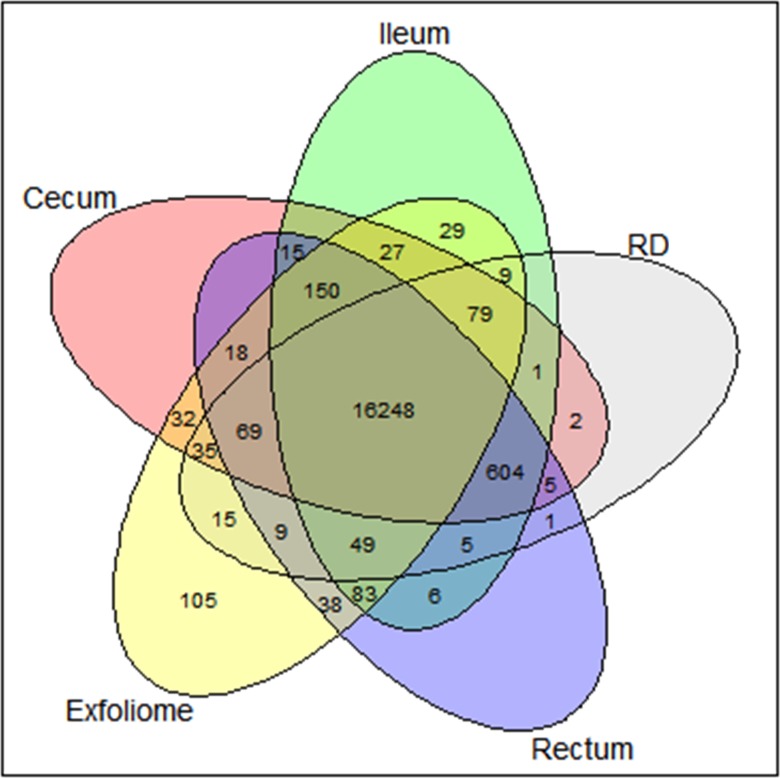
The equine exfoliome overlaps with the GI mucosal transcriptome from all anatomic sites examined.Venn diagram depicting the intersection of the exfoliome with the mucosal transcriptome from mucosal biopsies obtained from the ileum, cecum, rectum, and right dorsal colon (RD).